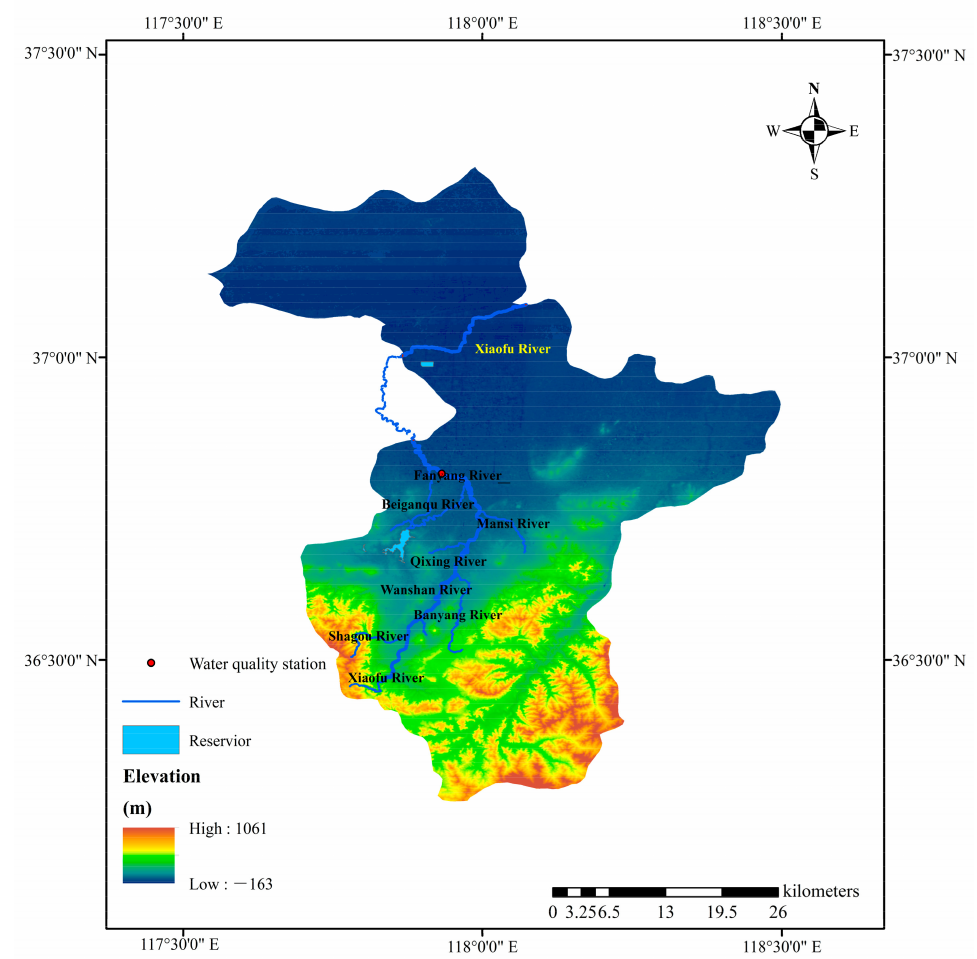
Figure 1. Overview map of the study